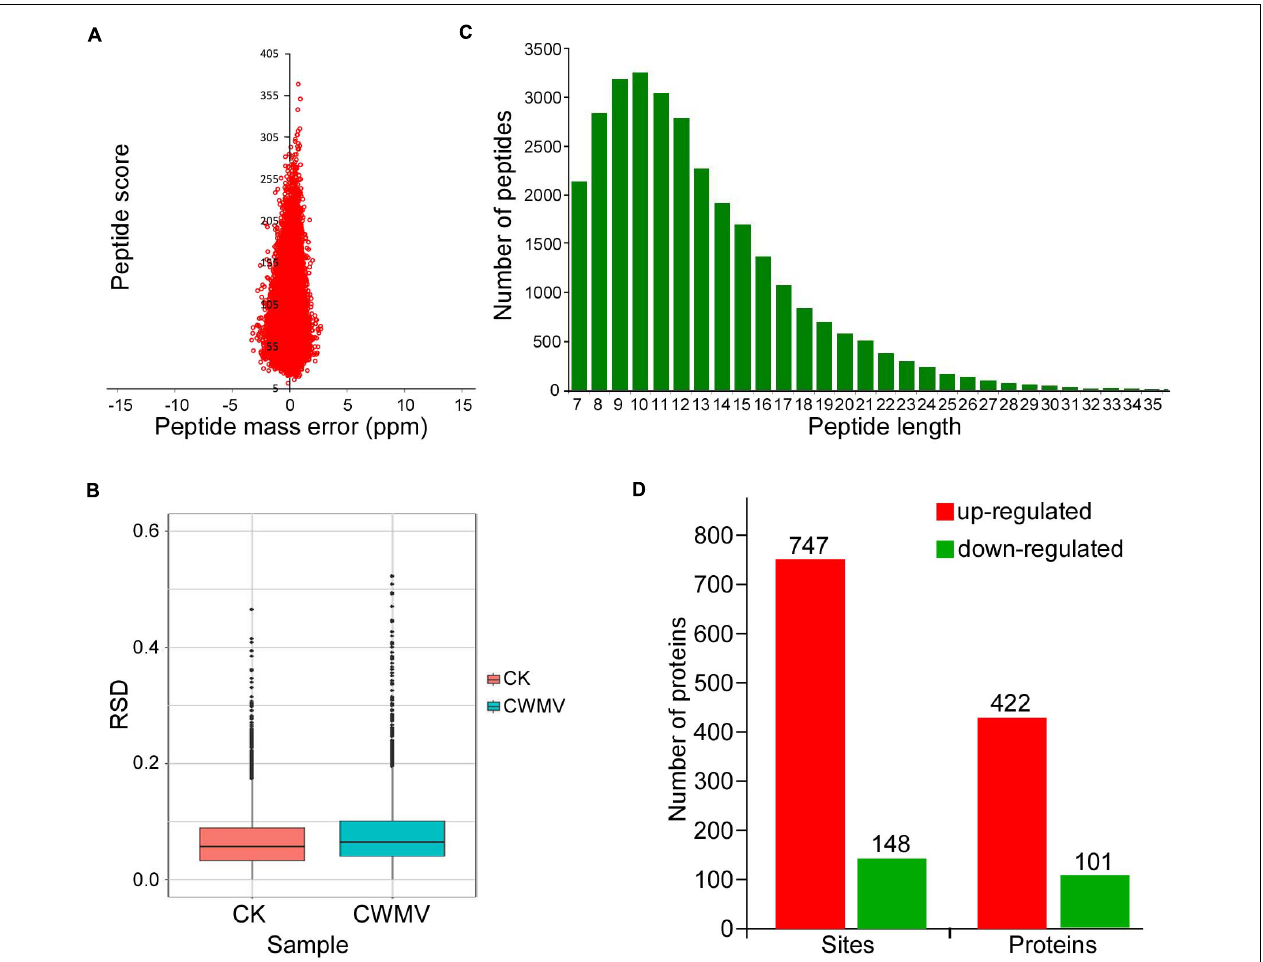
FIGURE 2 | Distribution and motif analysis of lysine acetylation sites. (A) Mass error distribution of all identified peptides. (B) Boxplot showing the sequence coverage of proteins that were quantified under each extraction condition. RSD, relative standard deviation coefficient. (C) Distribution of peptide length. (D) Number of lysine acetylation sites on peptides and proteins identified in CWMV-infected N. benthamiana leaf samples and uninfected leaf